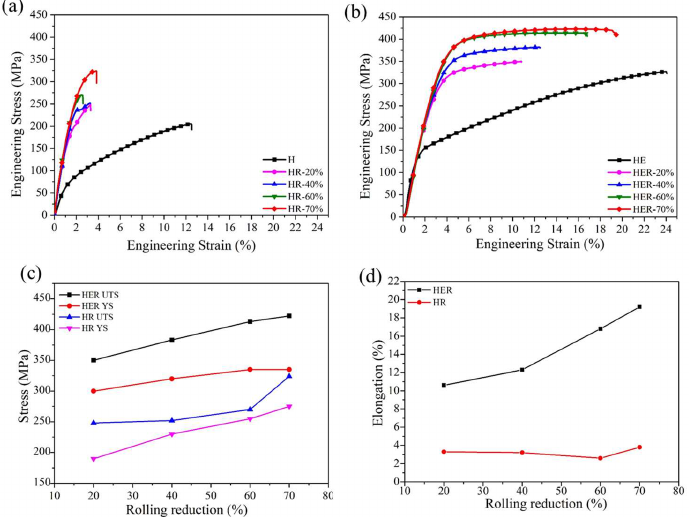
Figure 4. ( a , b ) Typical stress–strain curves of the AZ91 alloys at different processing states, and ( c , d ) tensile property comparisons of the HR and HER alloys presented in ( a , b ).